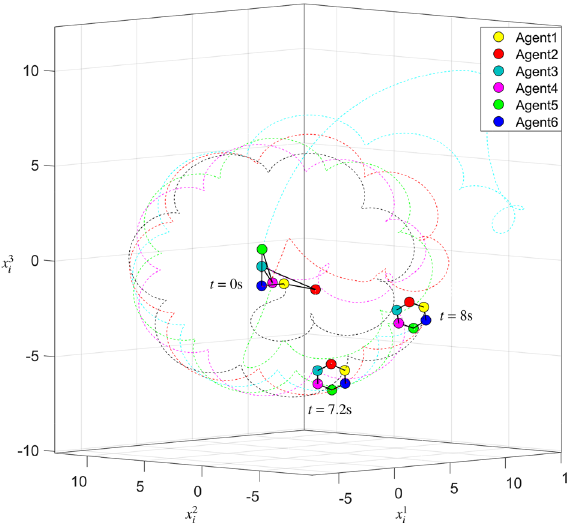
Figure 4. State trajectories of all agents with interaction silence.